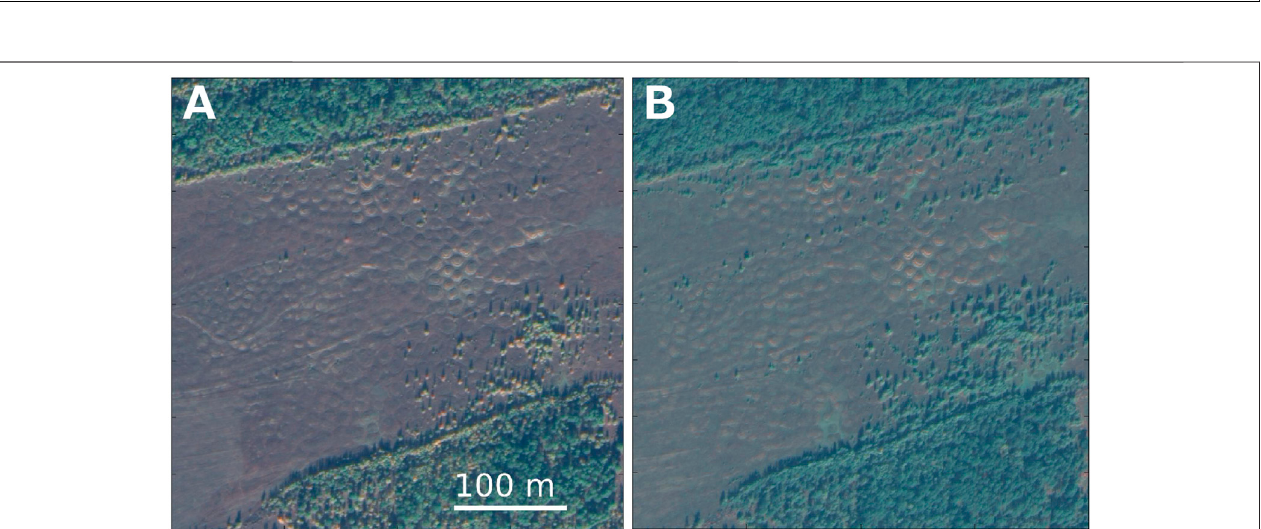
Frontiers in Earth Science |